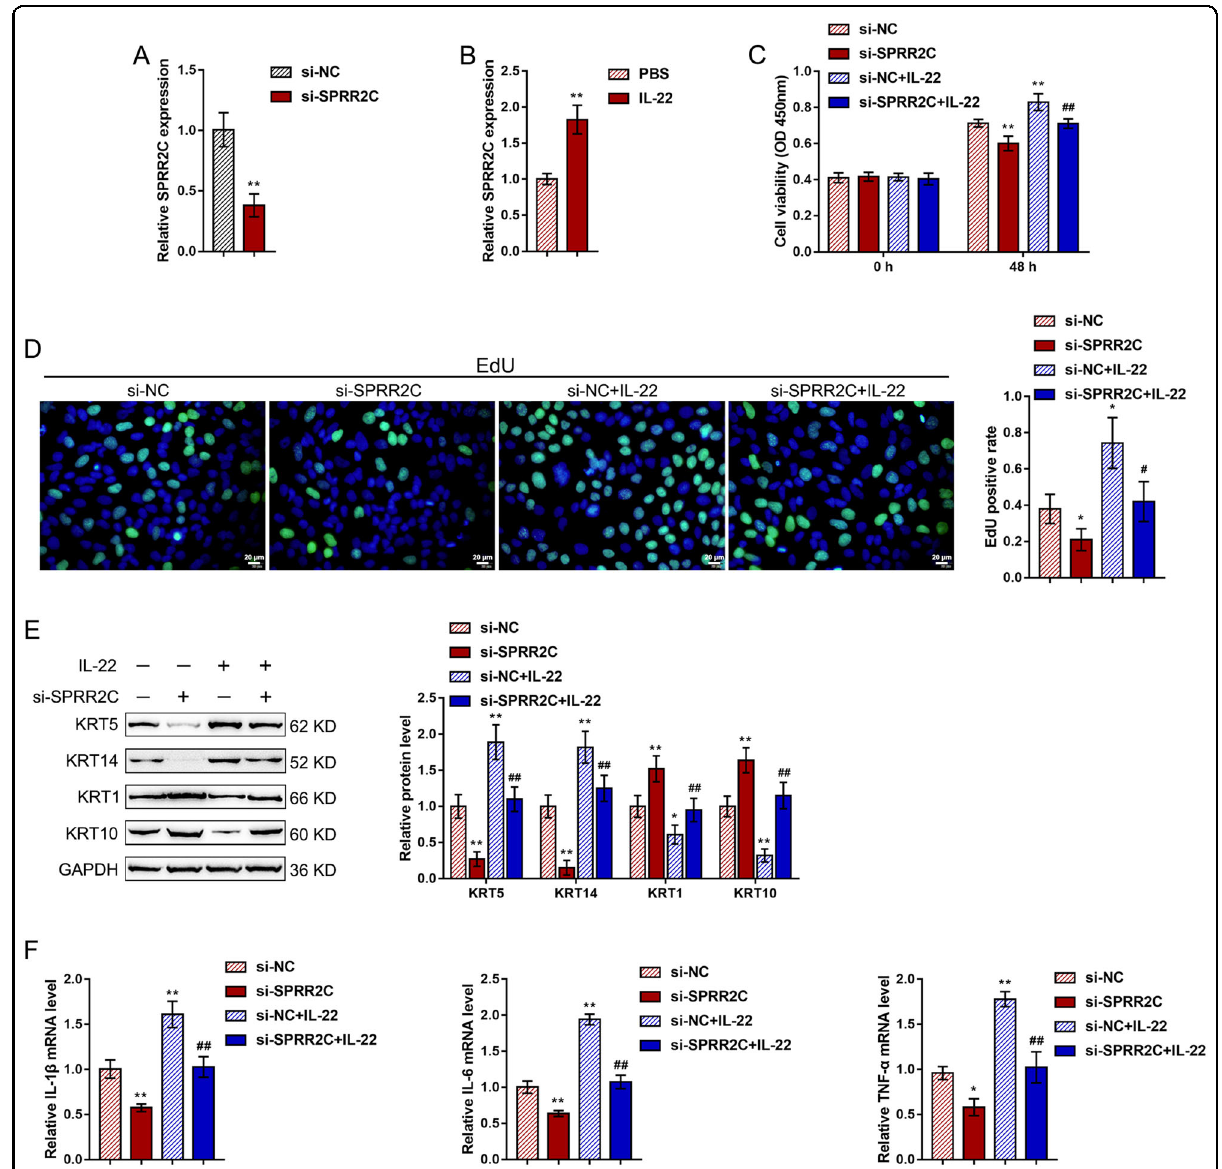
Fig. 2 Effects of SPRR2C on IL-22-induced human immortalized keratinocytes. A SPRR2C knockdown was conducted in human immortalized keratinocytes (HaCaT cells) by the transfection of si-SPRR2C1/2/3; the transfection ef fi ciency was con fi rmed by real-time PCR. Si-SPRR2C1 was selected for further experiments because of its high transfection ef fi ciency. B HaCaT cells were starved in serum-free DMEM for 24 h, treated with IL-22 (100ng/ml) in serum-free DMEM for another 24 h or not treated, and then examined for the expression of SPRR2C. Next, the HaCaT cells were transfected with si-SPRR2C in the presence or absence of IL-22 stimulation and examined for ( C ) cell viability by MTT assays; D DNA synthesis by EdU assays; E the protein levels of KRT5/14/1/10 by immunoblotting; F and the mRNA expression levels of IL-1 β , IL-6, and TNF- α by real-time PCR. * P < 0.05, ** P < 0.01, compared to the control group; # P < 0.05, ## P < 0.01, compared to the si-NC + IL-22